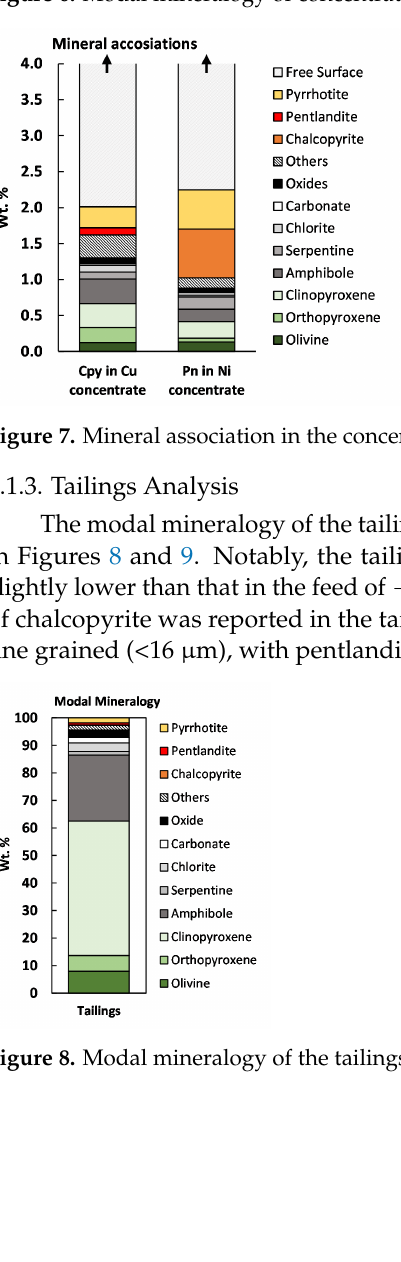
Figure 6. Modal mineralogy of concentrates.